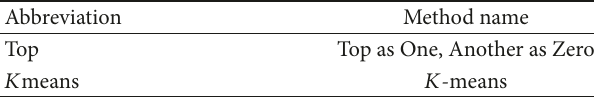
Table 4: Abbreviations for feature normalization